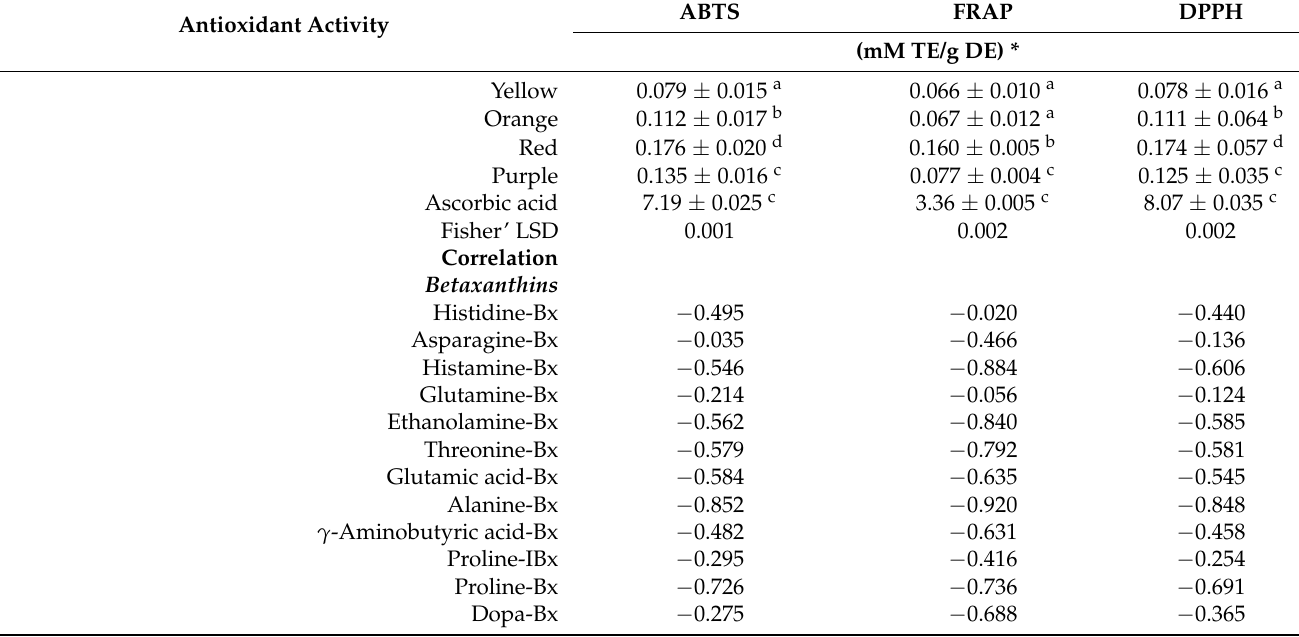
Table 3. Antioxidant properties of yellow, orange, red and purple flowers of P. grandiflora determined by ABTS, FRAP and DPPH assays and correlation coefficients between identified metabolites (abso- lute peak areas) and antioxidant activity (mM TE/g DE). Statistical significance is marked by font: boldface means 95% significance and very strong correlation (R = 0.7–1.0); italic font means 95% significance and strong correlation (R=